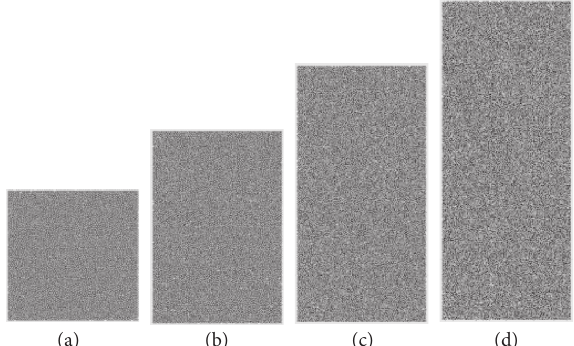
Figure 4: Rock specimens with different height-to-diameter